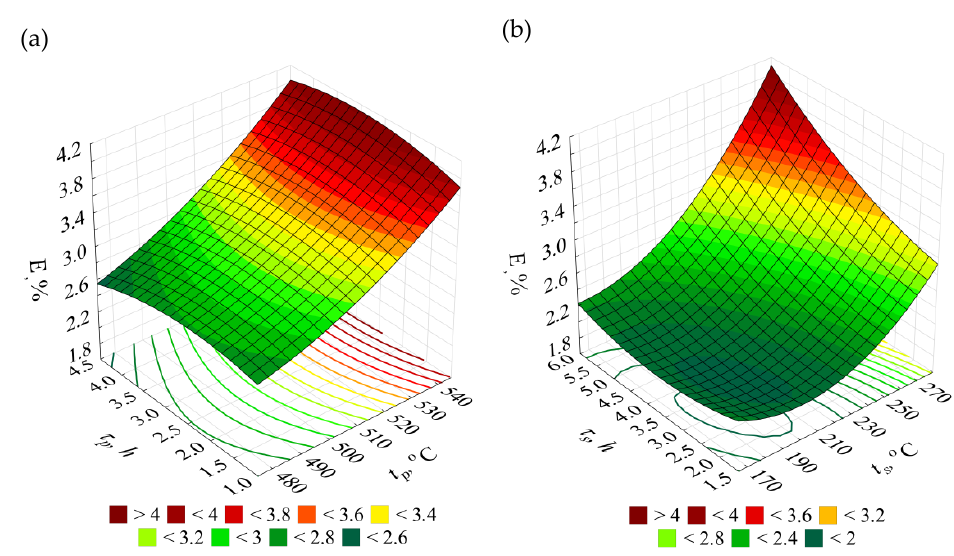
Figure 7. Effects of the T6 heat treatment parameters on unit elongation E of the EN AC–AlSi11(Fe) alloy for determined ( a ) t s = 280 °C, τ s = 6 h, ( b ) t p = 545 °C, τ p = 2.5 h.